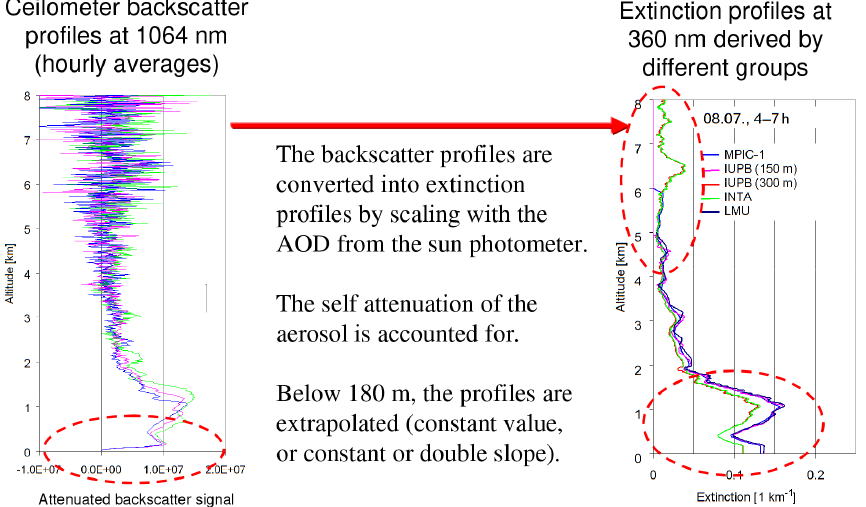
Figure 8. Left: hourly averaged backscatter profiles from the ceilometer measurements for the period 04:00–07:00 on 8 July 2013. Below 180m the values rapidly decrease to zero due to the missing overlap between the outgoing beam and the field of view of the telescope. Right: aerosol extinction profiles extracted by the different groups from the ceilometer profiles (assuming a constant extinction below 180m). The red circles indicate the height intervals with the larger deviations (IUPB 150m and IUPB 300m indicate profile extractions with different widths of the smoothing kernels: Hanning windows of 150 and 300m,